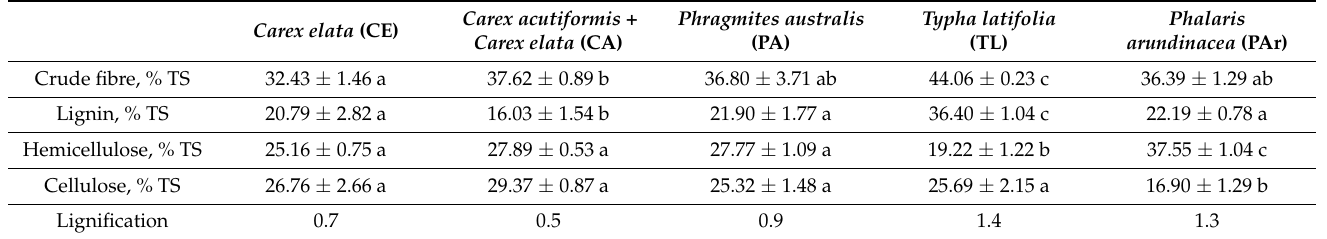
Table 2. Lignocellulose characteristics of fresh wetland plant material. Carex elata